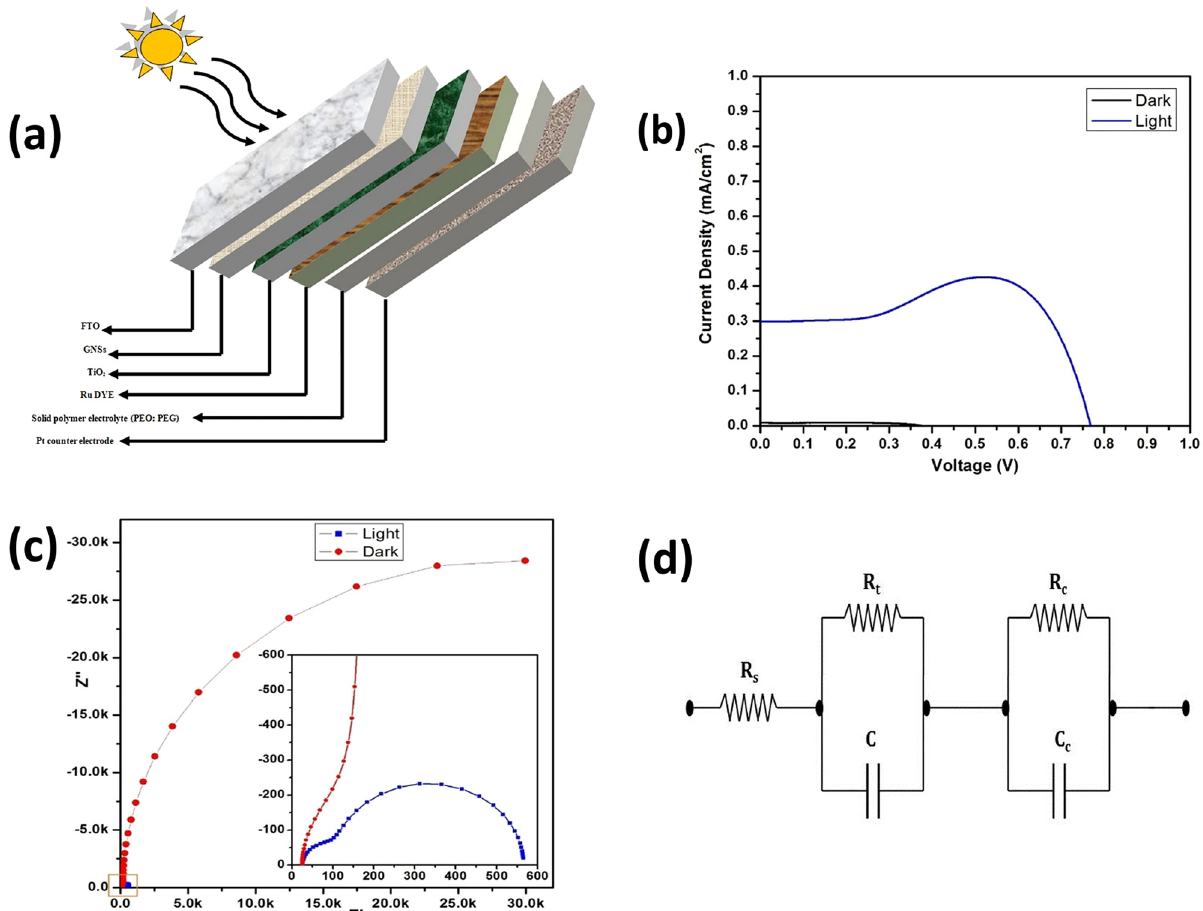
Figure 44: ( a ) Schematic of a designed DSSC with corresponding ( b ) J – V curves, ( c ) EIS curves, and ( d ) equivalent circuits. Copied with permission from ref. [ 92 ] ; Nature, 2021.